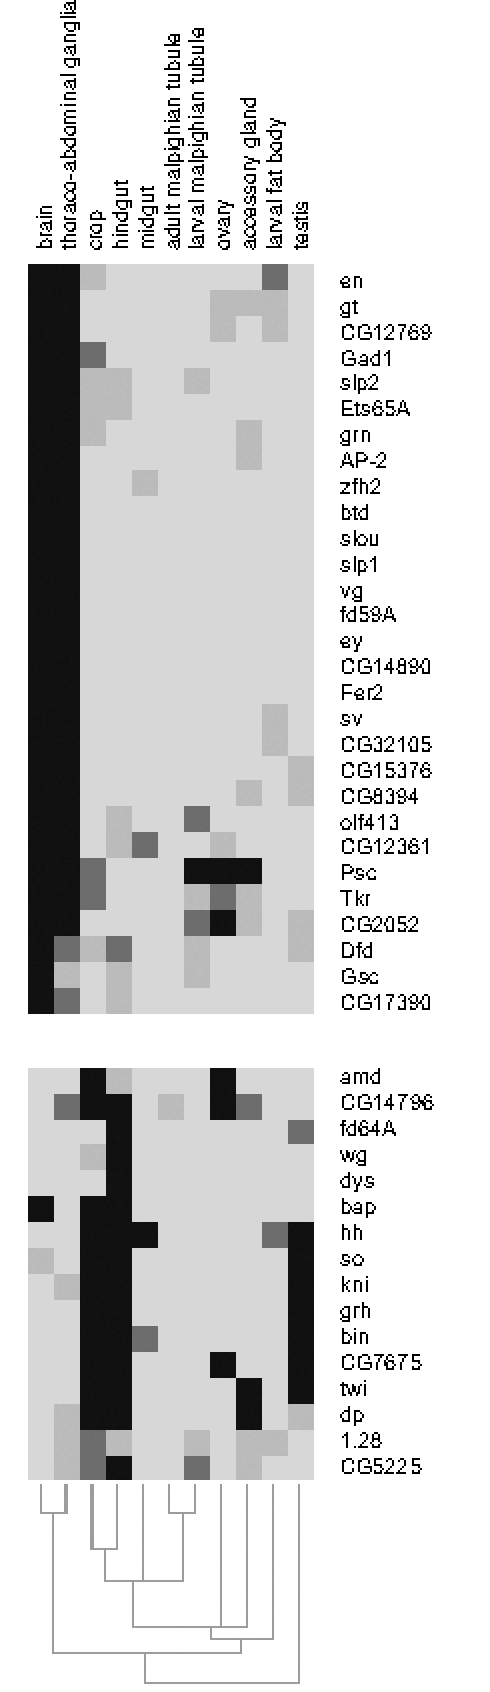
Tissue expression of Pc targets.Selected regions from the cluster analysis of 373 Pc target genes clustered according to expression in larval/adult tissues using the FlyAtlas expression data. Intensity represents the number of present calls in replicates (maximum 4). Related tissues cluster together and the selected regions show gene clusters for brain/thoraco-abdominal ganglia and crop/hindgut. Many genes relevant for early developmental decisions in these tissues are still expressed in the adult. The full cluster diagram for the 373 Pc target genes is given in Figure S5.